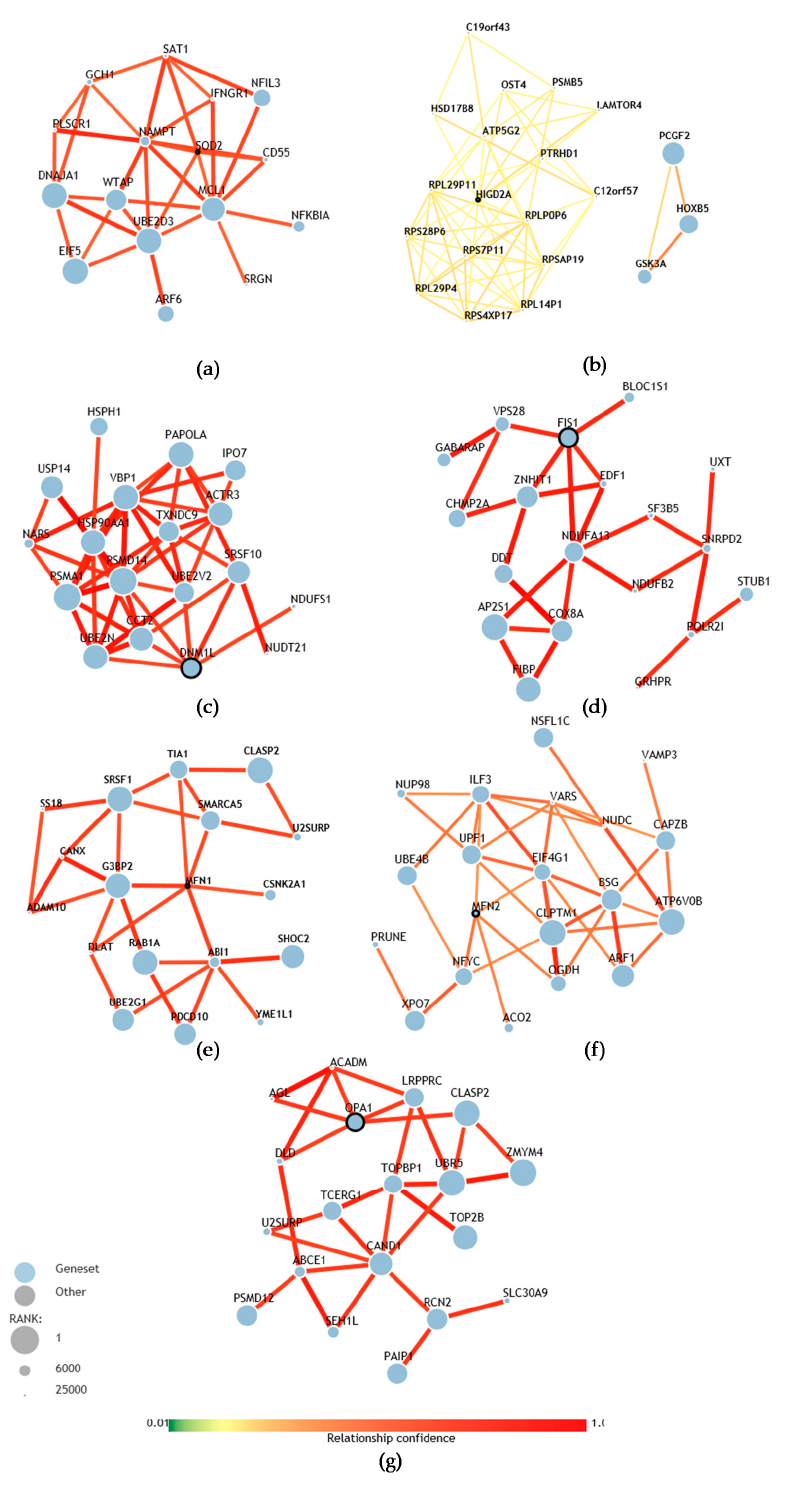
Figure 6. Prediction of gene association with the genetic bases of ASD. ( a ) Network of SOD2 genetic associations, ranked #12001 among all genes in the human genome based on the prediction of association with ASD. ( b ) Network of HIGD2A genetic associations, rank #21384. ( c ) Network of DRP1 ( DNM1L ) genetic associations, rank #2558. ( d ) Network of FIS1 genetic associations, rank #2822. ( e ) Network of MFN1 genetic associations, rank #22827. ( f ) Network of MFN2 genetic associations, rank #11607. ( g ) Network of OPA1 genetic associations, rank #3271